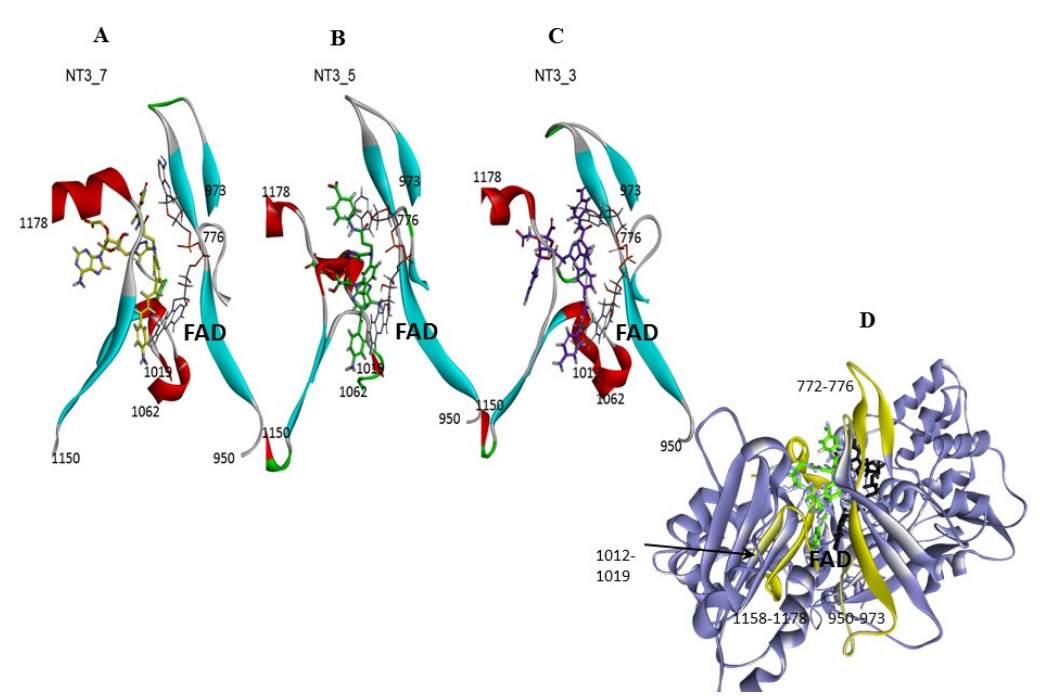
Figure 4. Gating elements of NT’s binding to the NADPH site of eNOS: the figure shows a simplified view of the NT3_7, 5, and 3, Panels A, B, C, respectively within their binding site. The gating elements are shown in yellow in Panel D (see also Figure A5 for a view with a 90° rotation). It is clearly seen that NT3_5 binding induced a fit of the protein due to its hydrophobic hub. NT3_5 binding induced a fit of the protein due to its hydrophobic